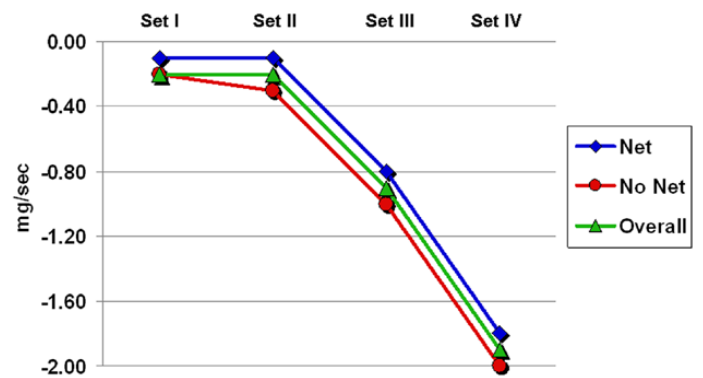
Figure 4 - Influence of laser settings and entrapment device on fragmentation efficiency characterized by absolute weight reduction per second of